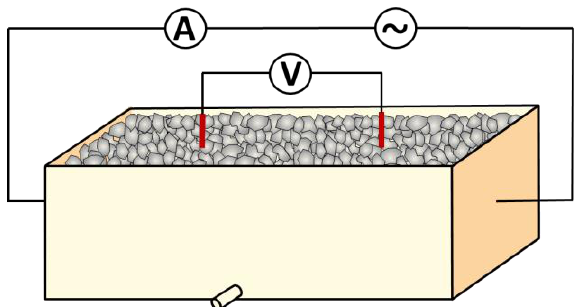
Figure 1. Schematic diagram of the Miller Soil Box. A represents the ammeter; V represents the voltmeter; ~ represents the power; the red bars represent the electrodes; the grey shapes inside the box represent the substrate.